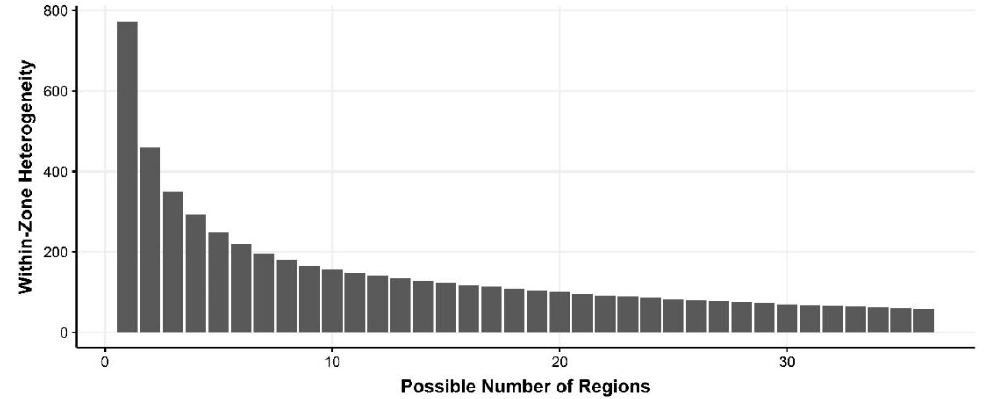
Figure 8. Within-zone heterogeneities of soil health indicators in Nigeria by possible number of regional regional divisions .